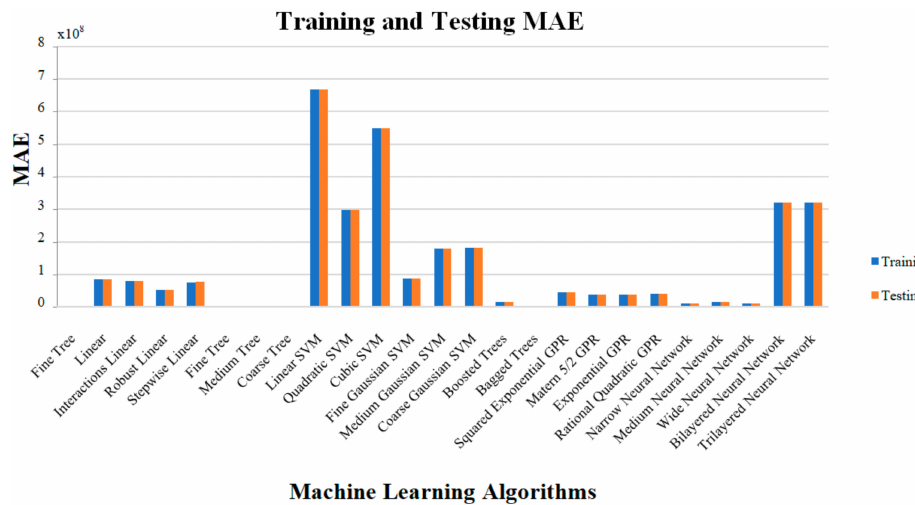
Figure 6. Training and testing MAE.